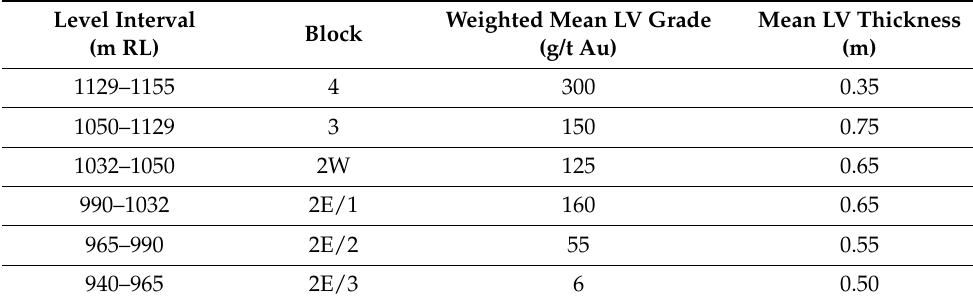
Table 4. Analysis of grades based on vertical elevation.